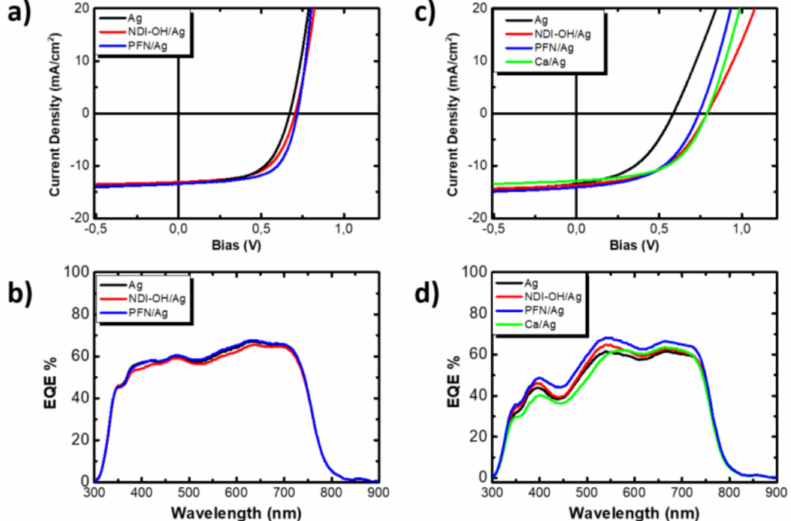
Figure 4. J–V characterization and external quantum efficiency (EQE) of the devices. PTB7-Th+ PC 71 BM with different interlayers (none, NDI-OH and PFN) ( a ) J-V and ( b ) EQE. PTB7-Th+ITIC with different interlayers (none, NDI-OH, PFN and Ca) ( c ) J-V and ( d )